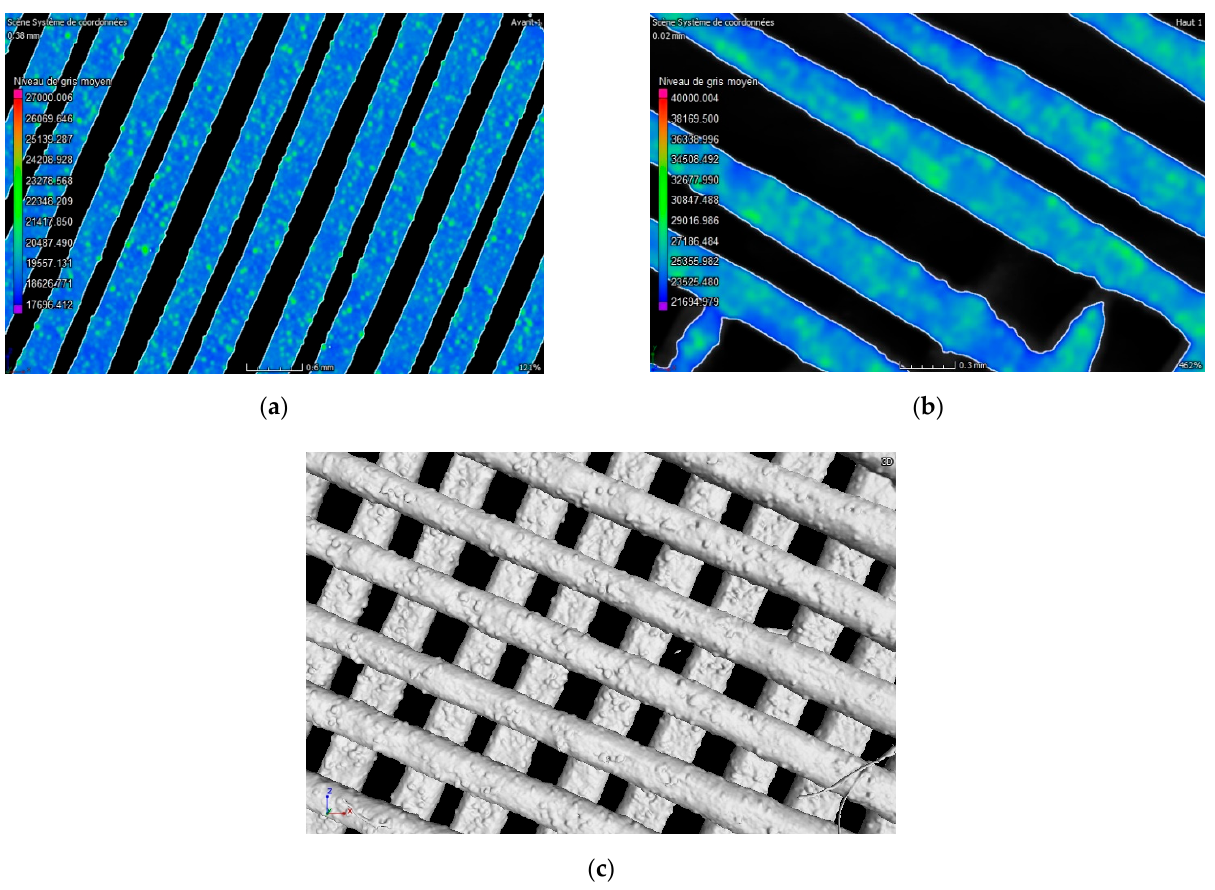
Figure 7. Evaluation of filler distribution in porous architecture of PCL/HA (20%) ( a ), PLA/HA (20%) ( b ), external view of porous architecture of PCL/HA (20%).